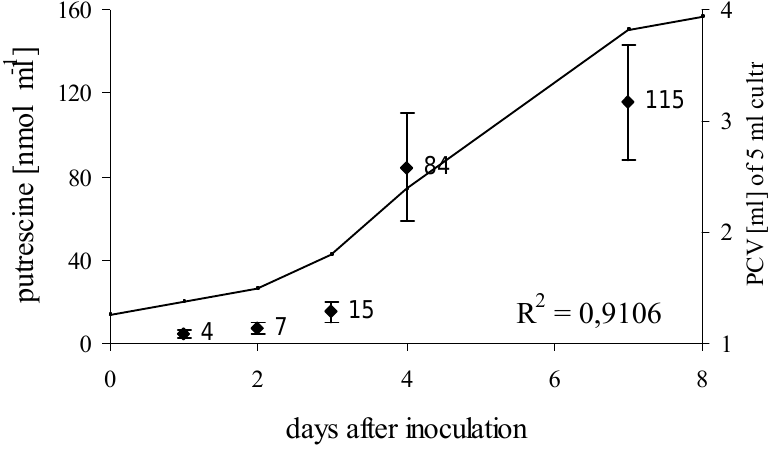
Figure 8. Dynamics of extracellular putrescine in the S2LS3 cell